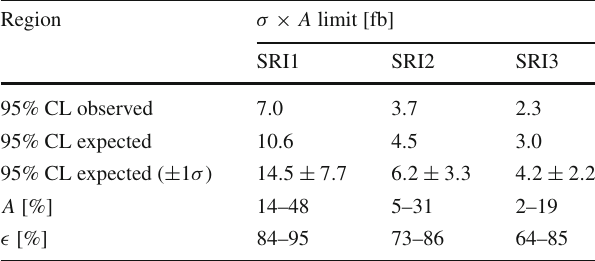
Table 7 The observed and expected limits at 95% CL on the fiducial cross section σ × A . The values of the fiducial reconstruction efficiency ( (cid:18) ), which is used for the calculation of the fiducial cross section, and of the acceptance ( A ) are also shown